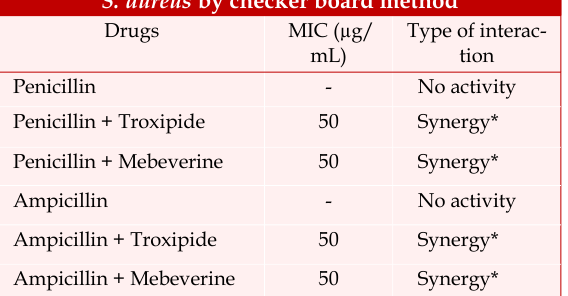
Synergistic interaction of combinations of antibiot- ics and non-antibiotics against